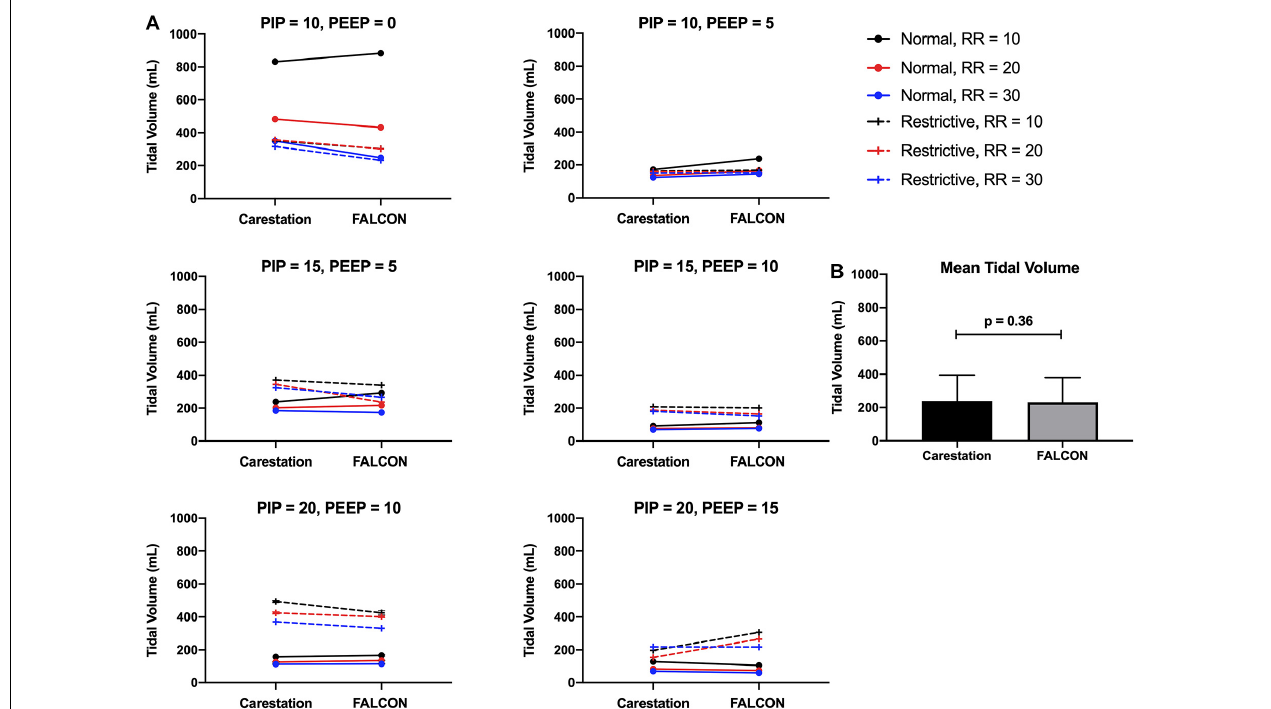
FIGURE 6 | (A) Mean tidal volumes produced by the CarestationTM and FALCON prototype ventilators calculated from 10 consecutive respiratory cycles. Data are paired with identical test conditions for the CarestationTM and prototype ventilators and grouped by target peak inspiratory pressure (PIP) and positive end expiratory pressure (PEEP) with varying lung compliance (normal = 74 mL/cm H 2 O or restrictive = 34 mL/cm H 2 O) and respiratory rate (RR; 10, 20, or 30 breaths per min). (B) Mean tidal volumes generated by the CarestationTM and prototype ventilators under all 36 test conditions ( p = 0.36, two-tailed paired Students t -test, error bars indicate standard